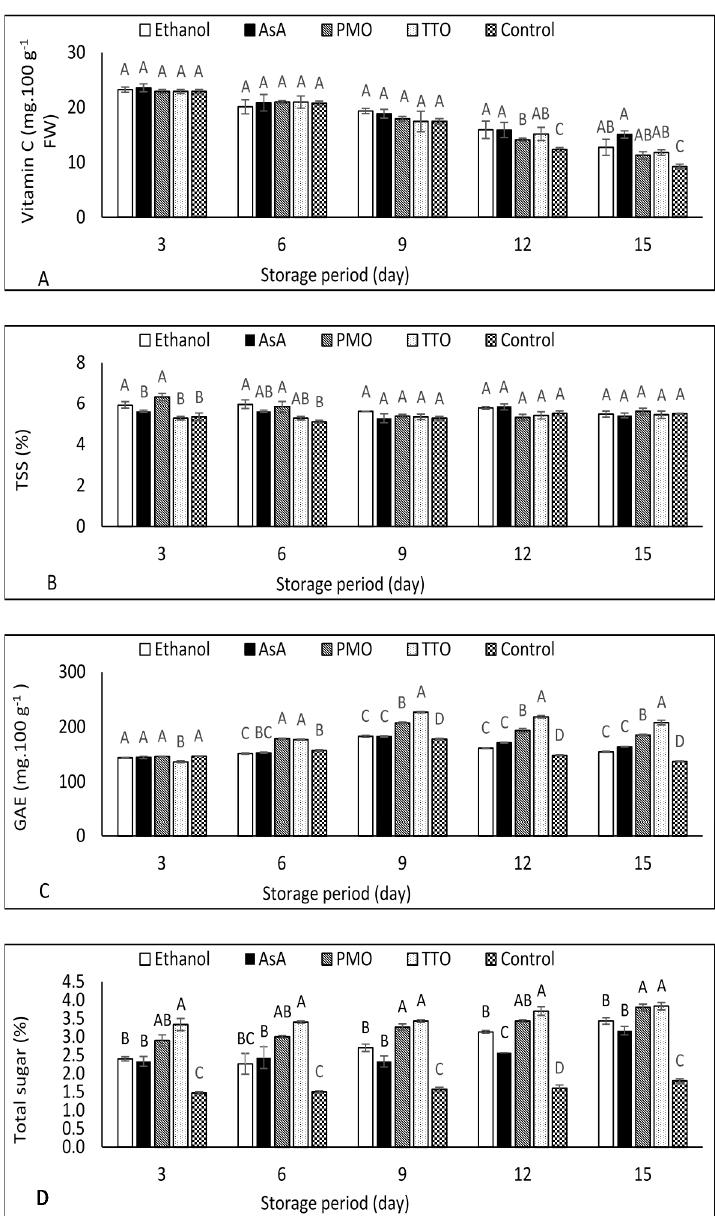
Figure 2. Effect of ethanol, ascorbic acid (AsA), peppermint oil (PMO), and tea tree oil (TTO) on ( A ) vitamin C, ( B ) total soluble solids (TSS), ( C ) total phenolic compound (TPC), and ( D ) total sugars of fresh-cut green bean pods stored at 5 ◦ C for 15 d. Different letters indicate significant differences ( p < 0.05) using the Tukey test at every storage point. Data are means of three replicates. Vertical bars represent standard error.